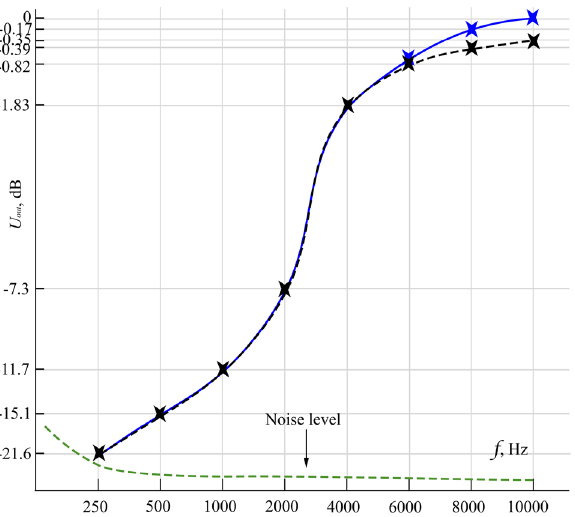
Figure 9. Output signal dependence on acoustic excitation frequency, or shortly the FRF of the system. The blue solid line is FRF at 0 ◦ C , and the black dashed line is FRF at and 0 ◦ C